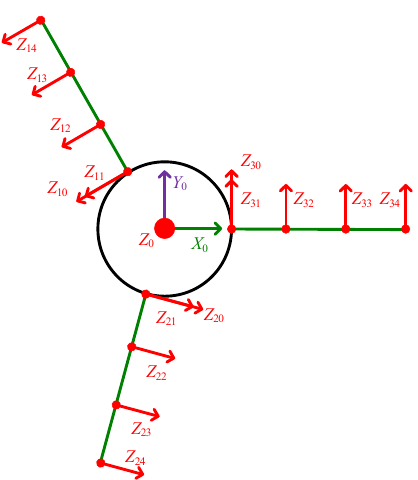
Figure 18. D-H coordinate system of the whole hand.